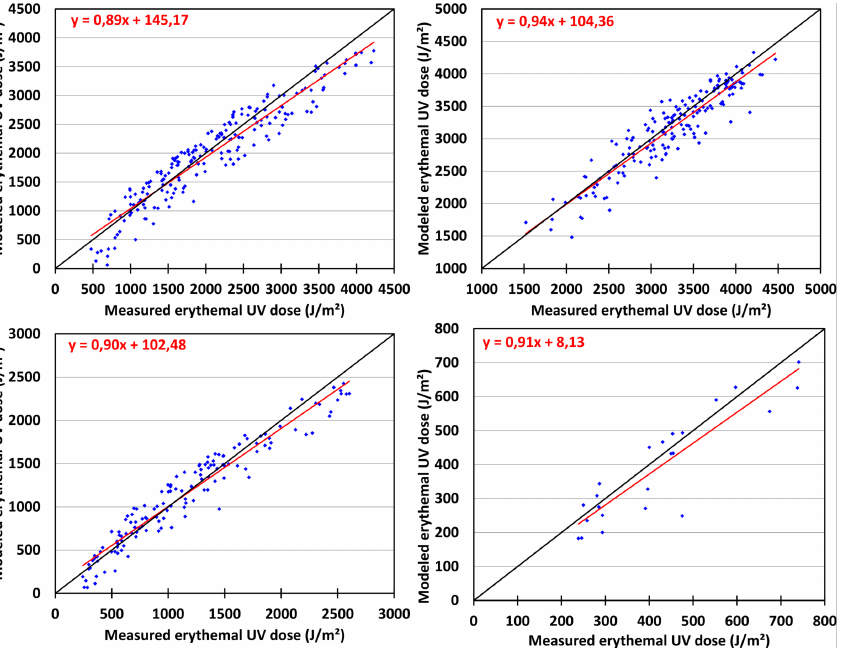
Figure 9. Scatterplots of the measured and modeled erythemal UV doses at Uccle for the 2009–2013 validation period for spring (upper left panel), summer (upper right panel), autumn (lower left panel) and winter (lower right panel). The red lines represent the regression lines of the data, and the black lines are the f (x) = x lines.